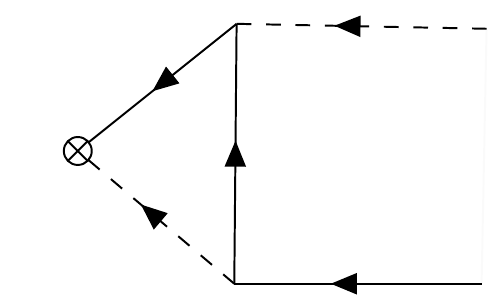
Figure 2 . Four point function at one loop.